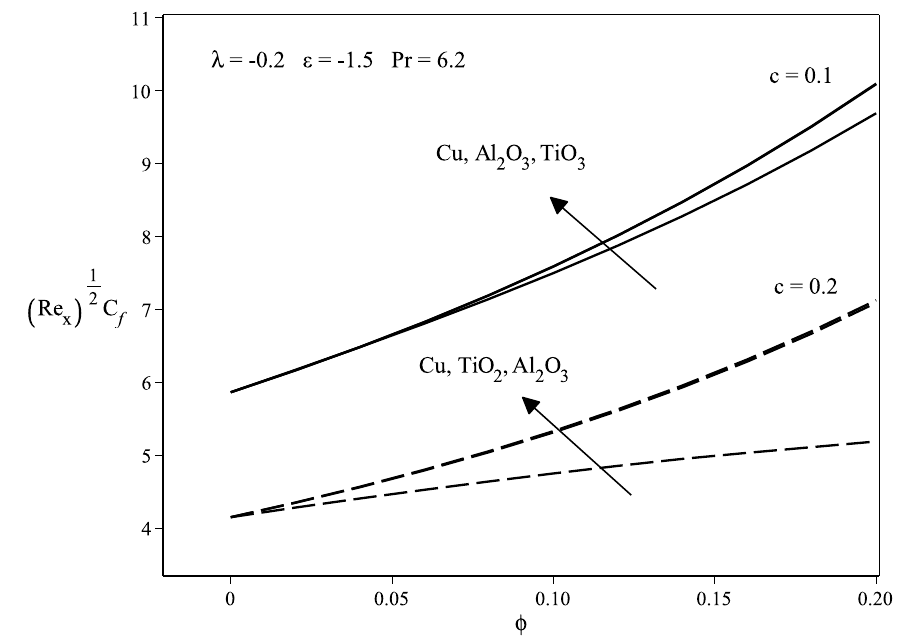
Figure 8. Variation of skin friction coefficients with nanoparticle volume fraction φ for different nanoparticles when c = 0.1 and c = 0.2.